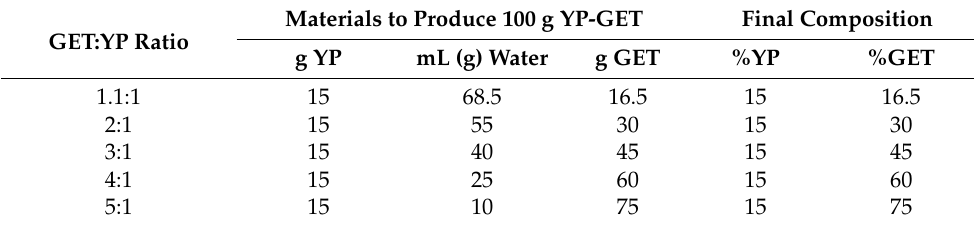
Table 3. Yeast particle, water, and 2:1:2 GET quantities required to produce 100 g of YP GET at five GET:YP ratios at a constant YP